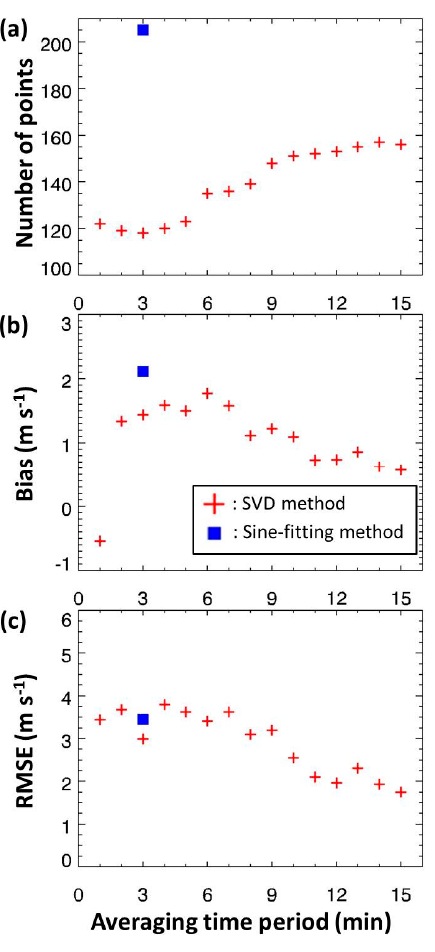
Figure 3. ( a ) Number of data points, ( b ) bias, and ( c ) root-mean-square error (RMSE) between radiosonde and wind Doppler lidar wind speed from the sine-fitting method and for variation in the averaging time interval in the SVD method.